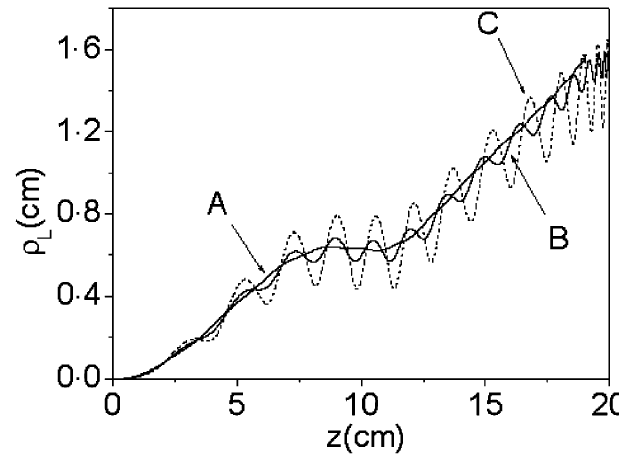
(cid:1) 8 keV , (B) W i